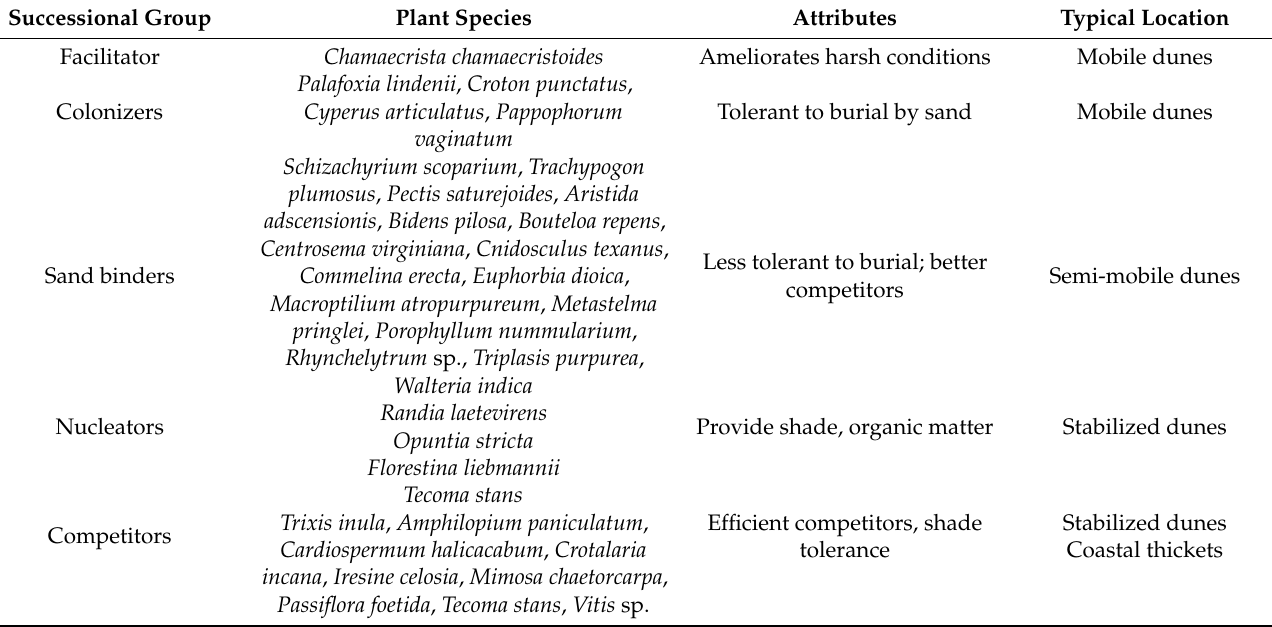
Table 1. Successional groups and plant species from the coastal dune community on La Mancha coastal dunes, Veracruz, Mexico. Successional groups were identified from field observations and literature review [34] and supported by a subsequent principal component analysis. The most abundant species are shown for each group. In addition, plant attributes and typical locations within the dune system are presented for each functional